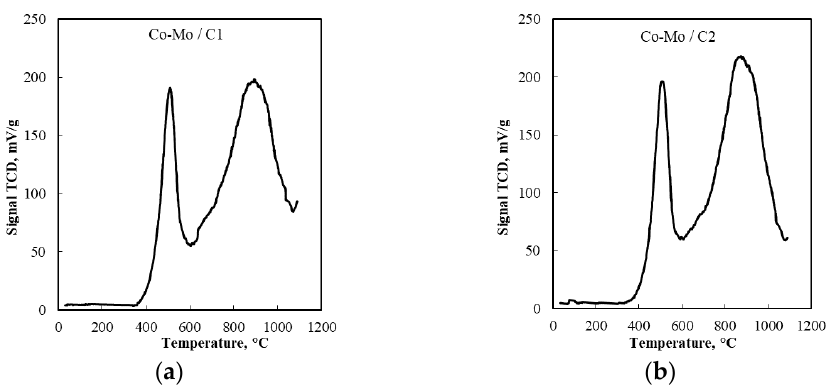
Figure 7. ( a ) Temperature-programmable catalyst reduction of Co-Mo/C 1 . ( b ) Temperature-programmable catalyst reduction of Co-Mo/C 2 . Table 3. Results of temperature-programmed catalyst reduction.